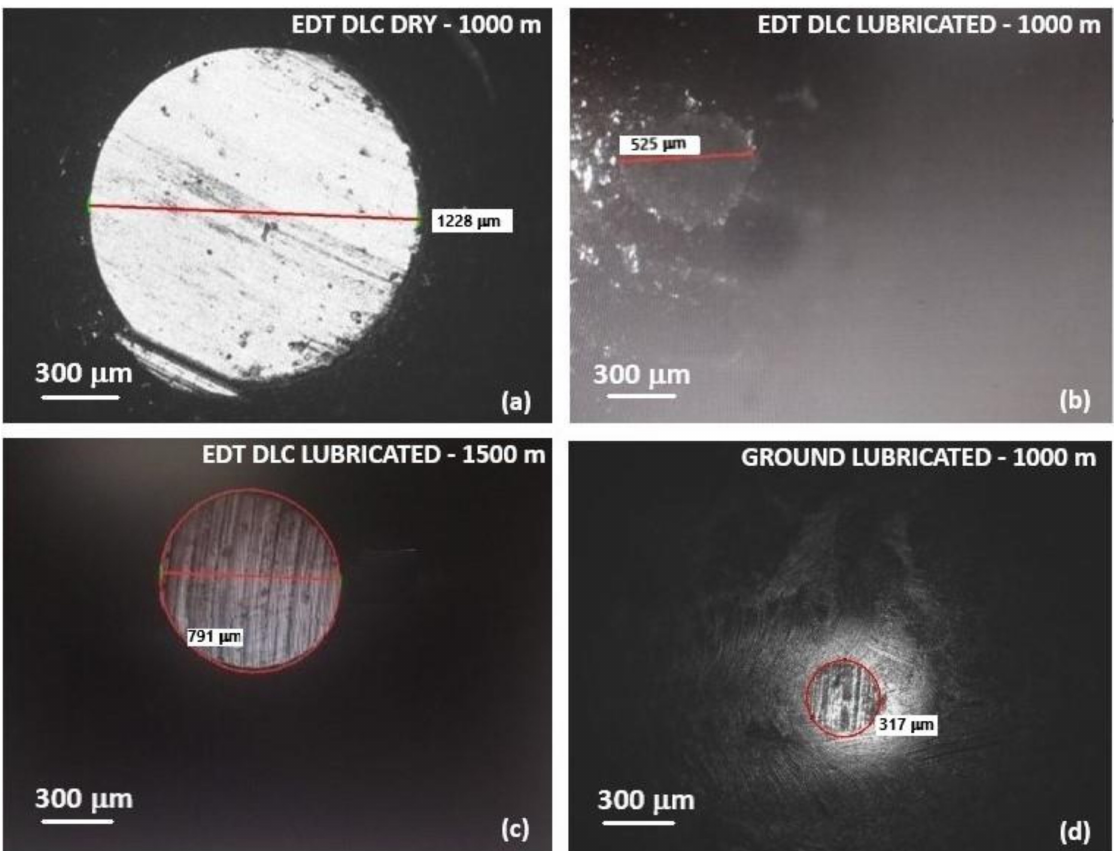
Figure 14. Optical microscopy of the wear scars produced on the balls that slid against the different specimens: ( a ) EDT DLC dry sliding, 1000 m; ( b ) EDT DLC lubricated sliding, 1000 m; ( c ) EDT DLC lubricated sliding, 1500 m; and ( d ) ground- lubricated sliding, 1000 m.